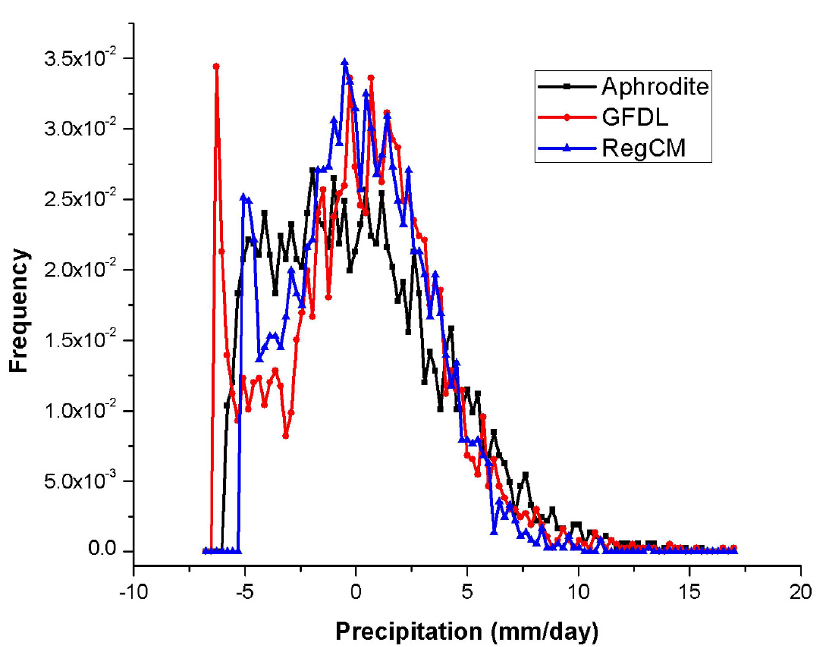
Figure 7. Probability density function of the JJAS precipitation anomaly for land points of the domain (Figure